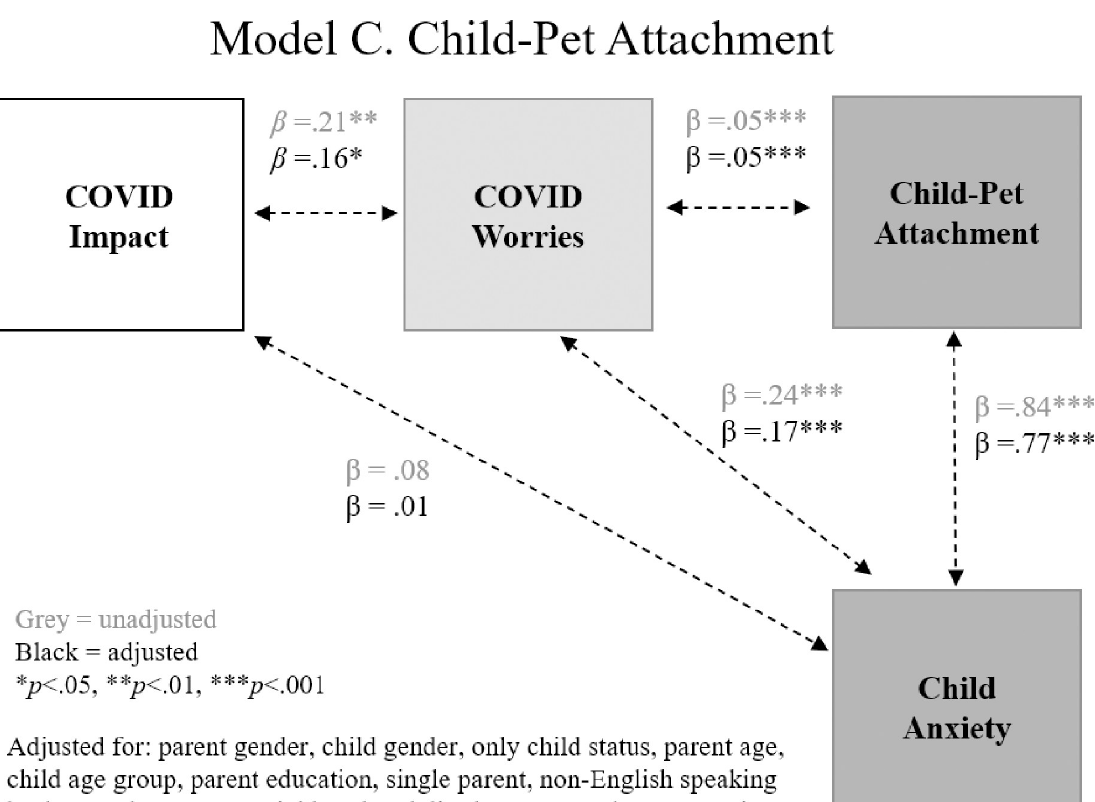
Fig 5. Model C: Associations between COVID-19 impact and worries, child-pet attachment and child anxiety.